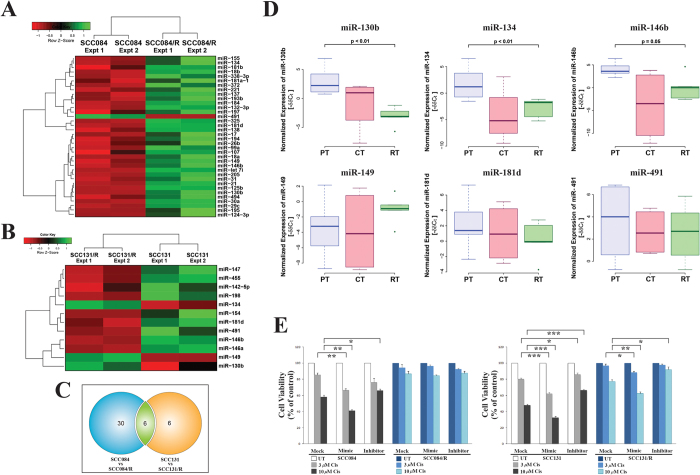
Cisplatin-resistant specific miRNA selection from cisplatin-resistant and parental OSCC cell lines and validation by means of in vitro (altering the endogenous miR-level) and in vivo (using clinical samples) analysis.(A) Cluster of 36 miRNAs (listed on the right) which show significant differences (p ≤ 0.05) in the expression profile in SCC084/R cells compared with that in SCC084 cells. (B) Cluster of 12 miRNAs (listed on the right) which show differential expression profile in SCC131/R cells compared with that in SCC131 cells. In figure (A,B) heatmap was generated using the normalized expression values (z-score of ∆CT) of those significantly (p ≤ 0.05) differentially expressed miRNAs. Each column represents the expression values of miRNAs from an independent experiment (two different passages of the cell line were used and displayed as Expt 1 and Expt 2) with three technical repeats. (C) Venn diagram on total number (in parenthesis) and overlapping number of differentially expressed genes calculated in the cell line pairs consisting the cisplatin resistant to their parental cells. (D) Box plots of endogenous levels of six resistance specific miRNAs in primary tumour (PT, n = 6), neoadjuvant chemotherapy treated tumours (CT, n = 4) and recurrent rumours (RT, n = 5) in patients with OSCC. Total RNA was isolated and subsequently used for quantitative real time-PCR. The negative values of miRNA expression (−∆∆CT) were plotted after normalisation to the expression of U6 (endogenous control) and to the expression of miRNA in adjacent normal tissues. (E) MTT assay was used to validate the role of miR-134 in resistance development, the resistant (SCC084/R; SCC131/R) and parental (SCC084; SCC131) cell lines through altering its endogenous level of miR-134 expression. Cells were transfected either with miRNA mimic or miRNA inhibitor or control (Mock) using Lipofectamine 2000. Cells were subsequently treated with cisplatin after transfection and incubated for 48 hrs. Then cell viability was measured to assess the cisplatin mediated cytotoxicity in miR-134-overexpression and -inhibition condition in these OSCC cell lines. Data represent three independent experiments and expressed as mean ± SE. *p < 0.05, **p < 0.01, ***p < 0.001.